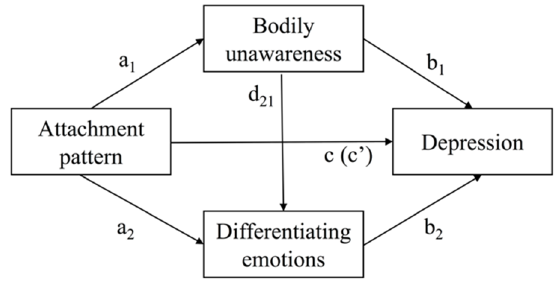
Figure 1. General serial multiple mediation model.